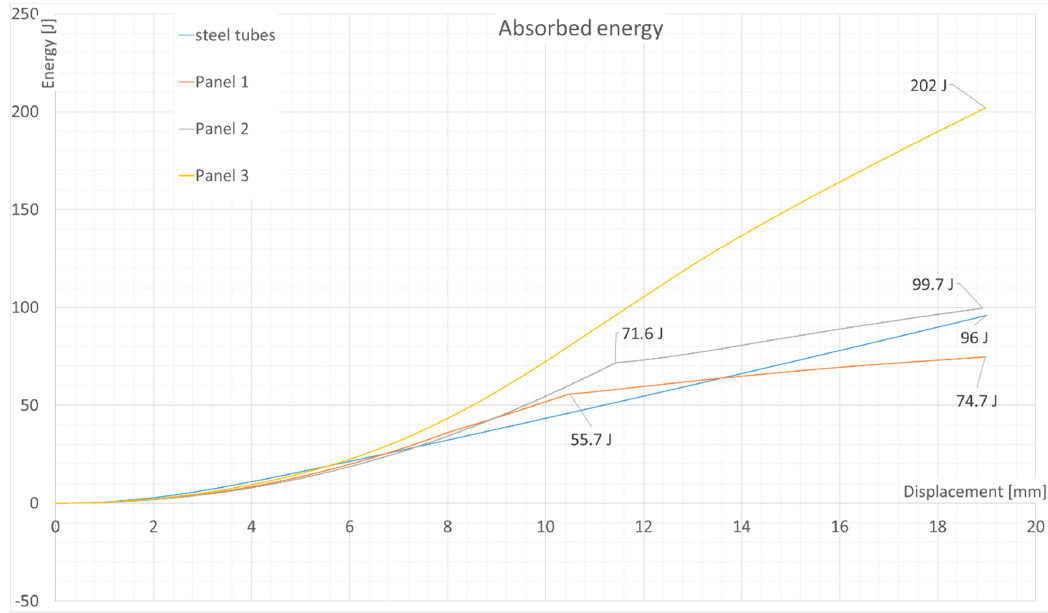
Figure 5. Three-point bending test results: Energy absorbed as a function of displacement.